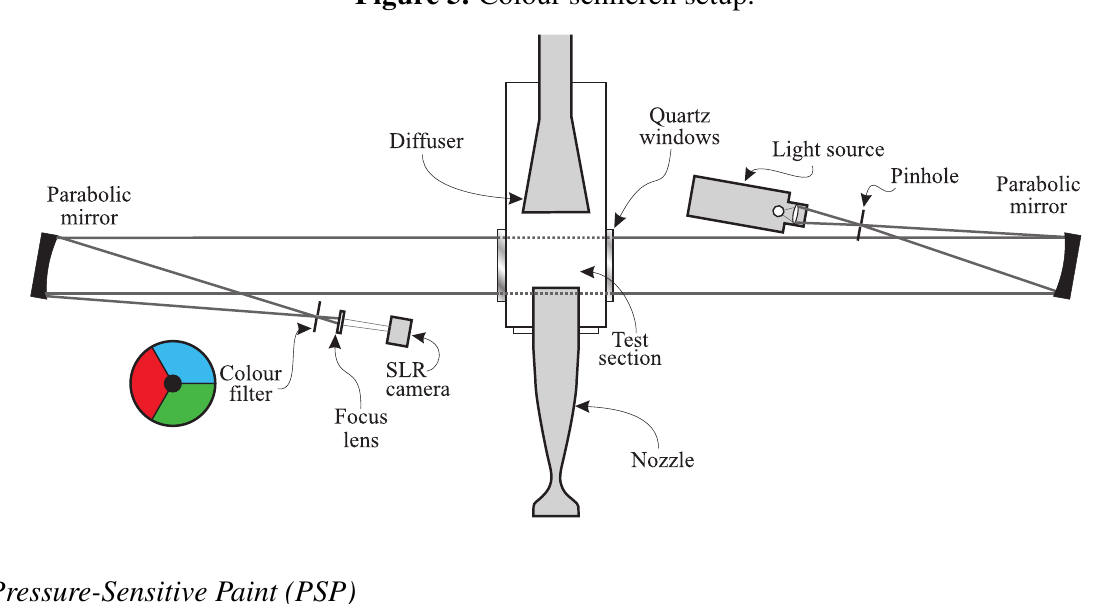
Figure 5. Colour schlieren